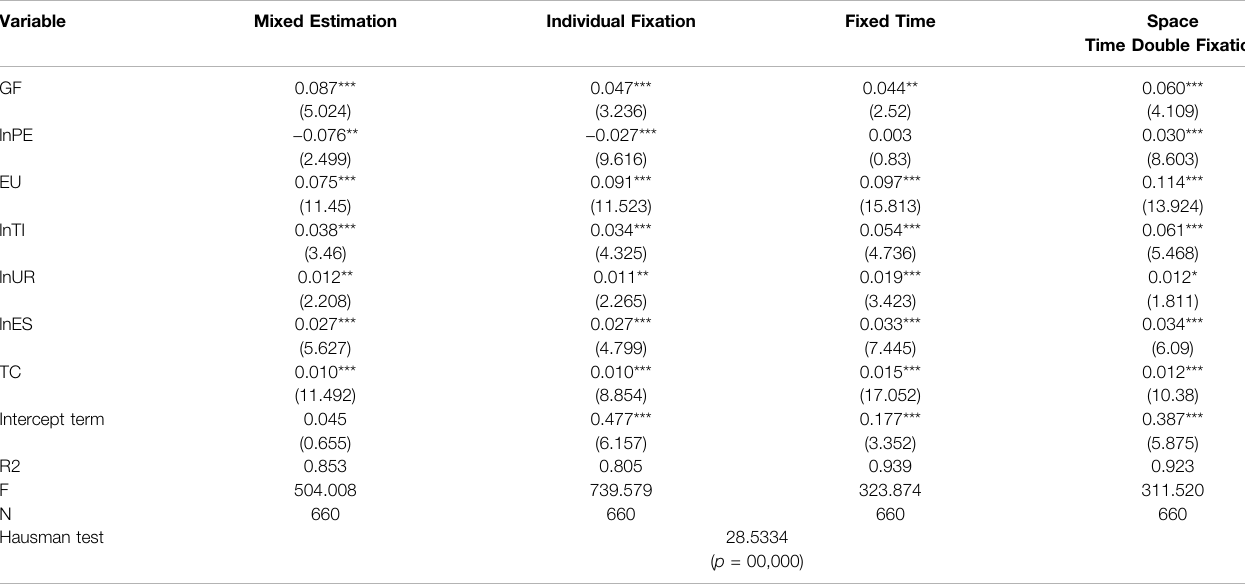
TABLE 2 | Estimation results for the common panel regression